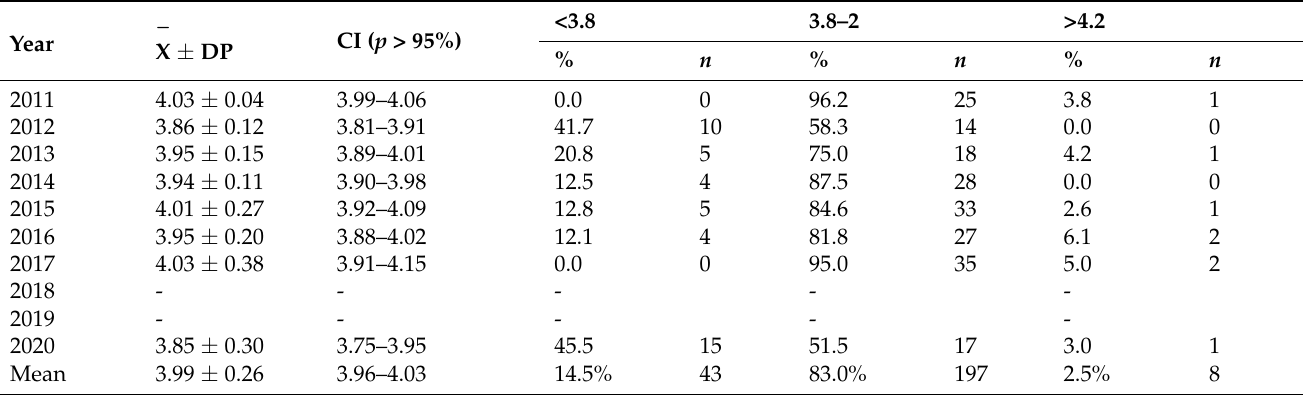
Table 9. Corn silages’ pH index (mean ± SD) sampled in the state of Paran á , Brazil in ten summer crops (2011–2020).